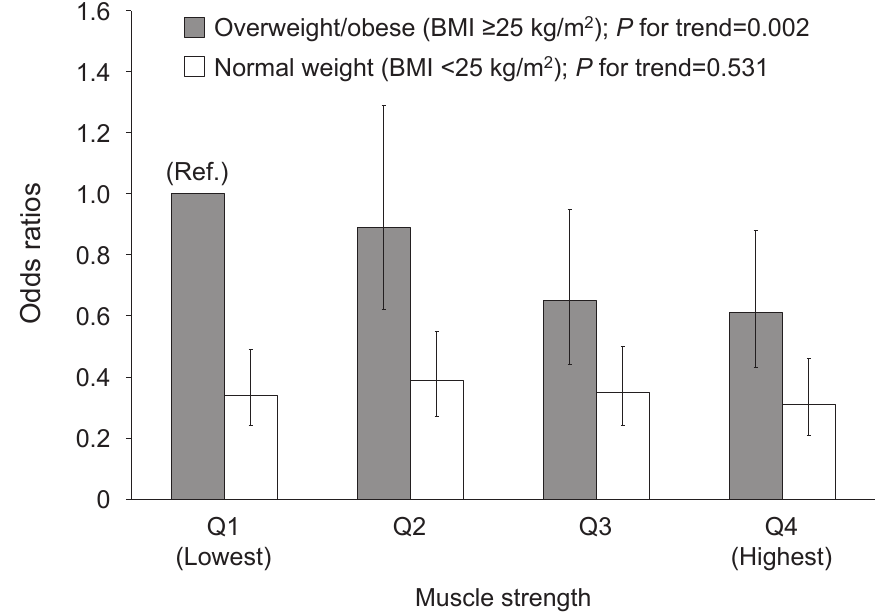
Figure. Multivariable-adjusted odds ratios and 95% con fi dence intervals for prevalence of type 2 diabetes, according to combined muscle strength categories and obesity status, after adjustment for age, systolic blood pressure, cigarette smoking, alcohol intake, and family history of